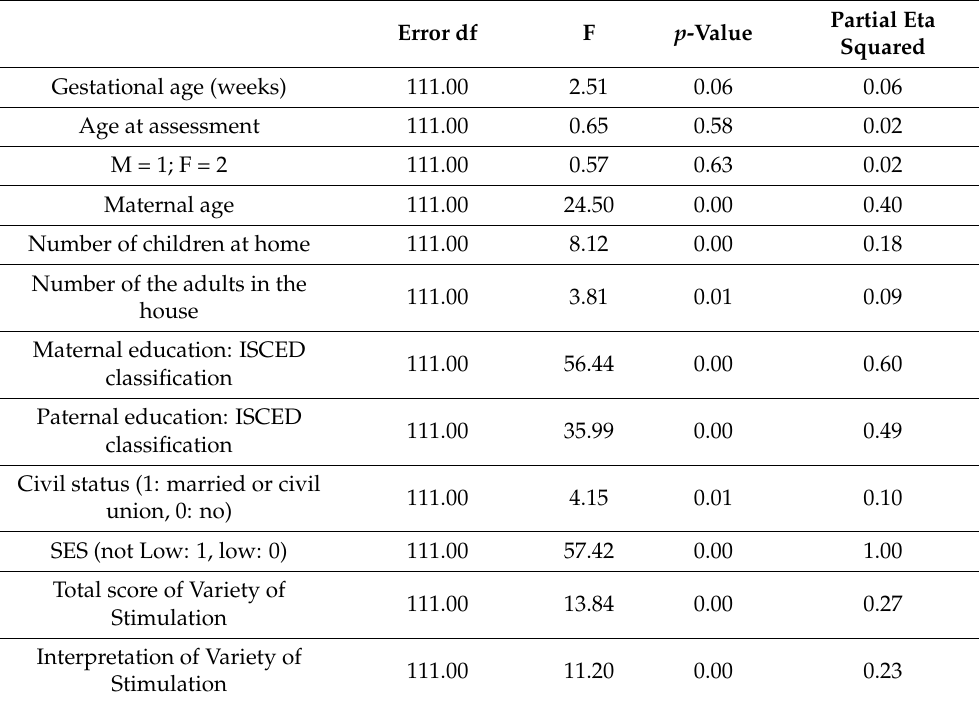
Table 2. Comparison between the